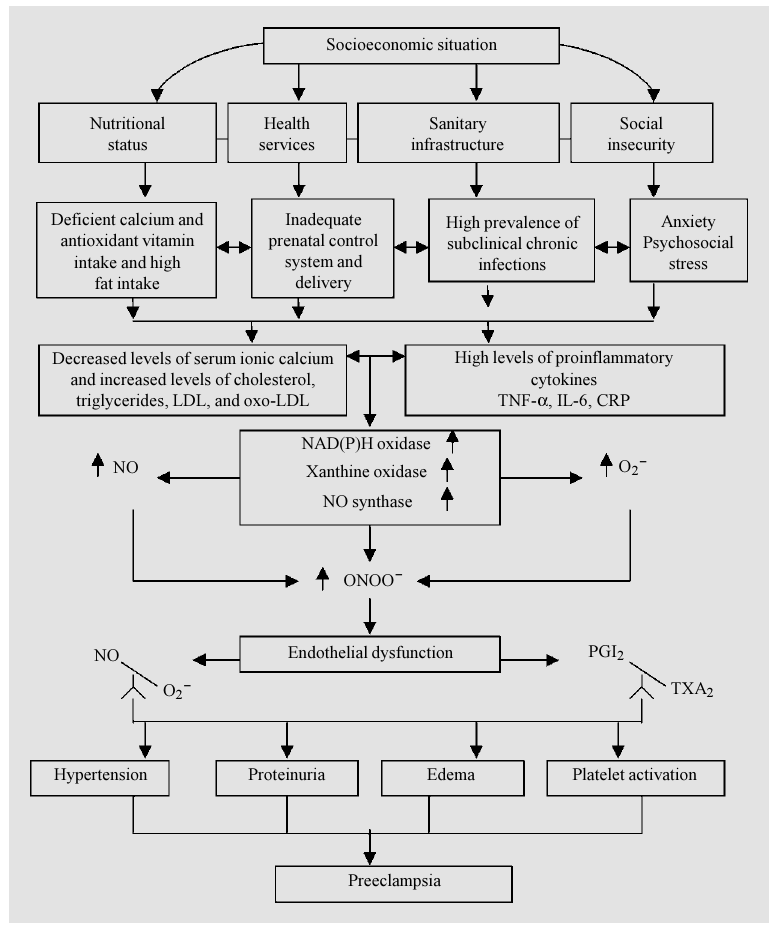
Figure 1. Interaction between different social, economic, nutritional and environmental factors that contribute to creating an imbalance between nitric oxide/superoxide (NO/O 2- ) that leads to the subsequent development of preeclampsia. CRP, C-reactive protein; PGI 2 , prostaglandin I 2 ; TXA 2 , thromboxane A 2